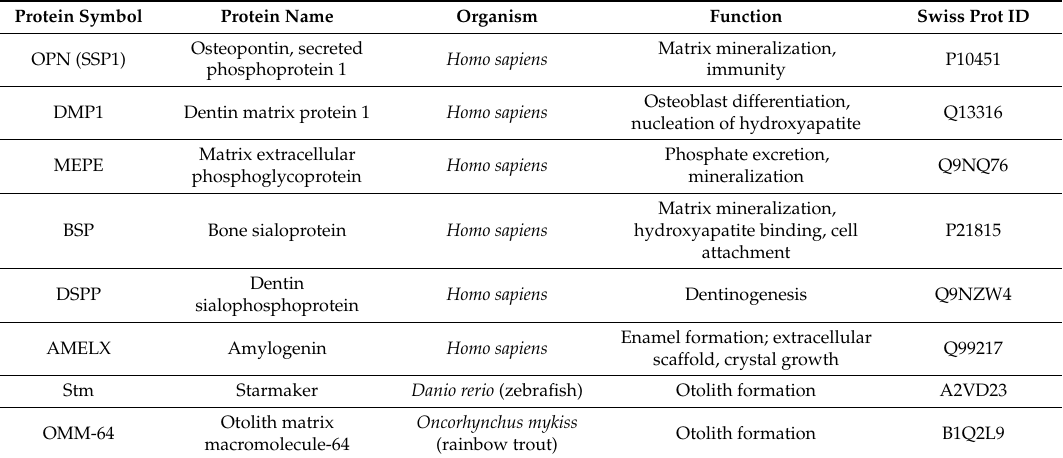
Table 1. The best characterized calcium-binding proteins involved in